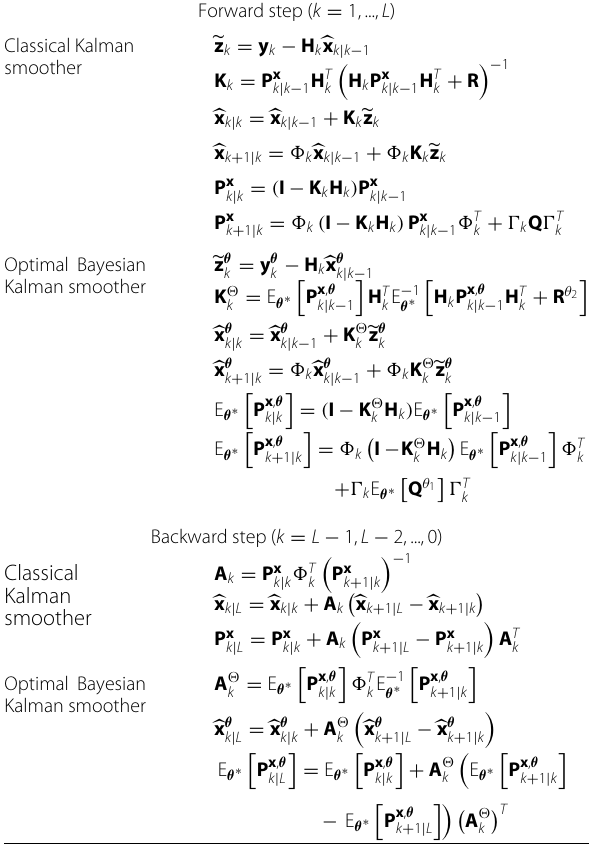
Table 1 Comparison of the recursive equations for the classical and the proposed optimal Bayesian Kalman smoothers Forward step ( k = 1,..., L